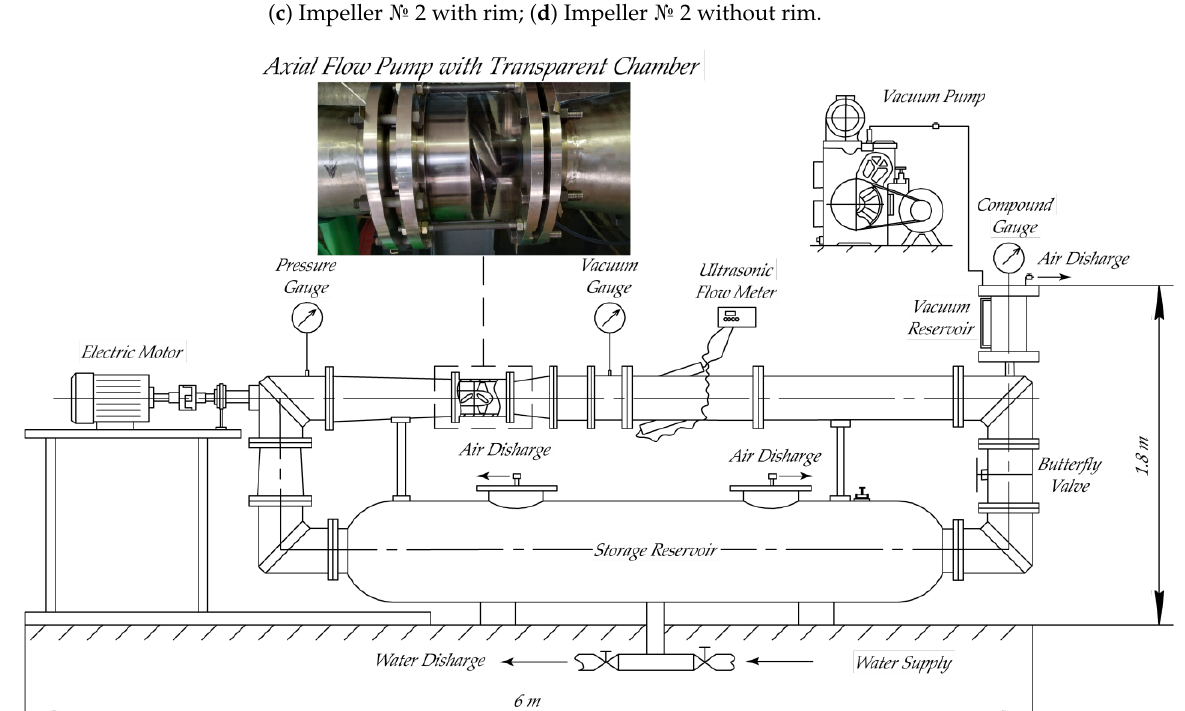
Figure 2. Experimental complex for testing axial-flow